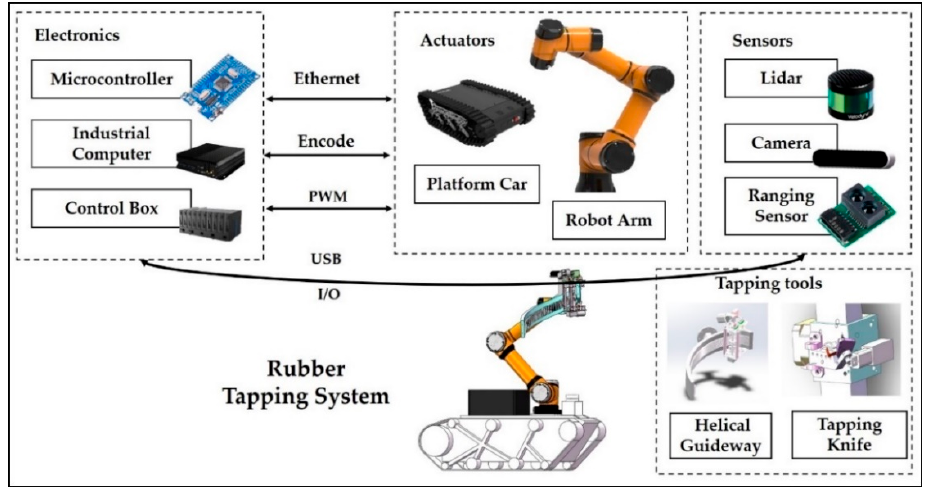
Figure 11. The structure of a rubber tapping robot.